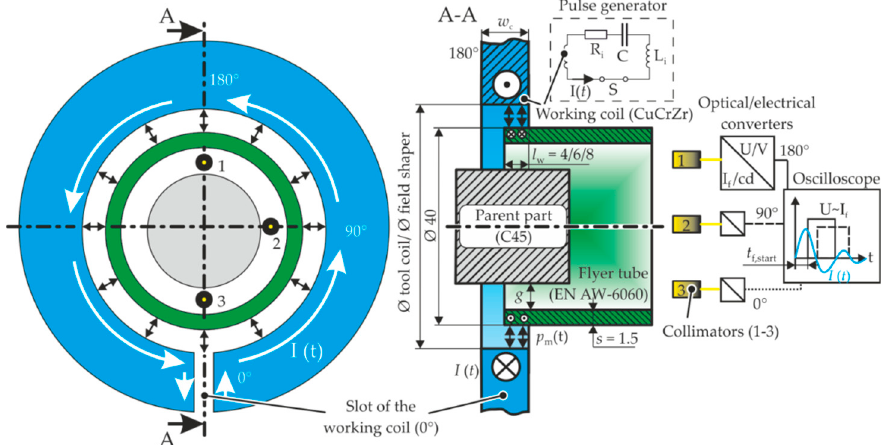
Figure 1. Basic setup for magnetic pulse welding (MPW) of tubes to cylinders (all values in millimeters, not true to scale, position of all parts is fixed during MPW).